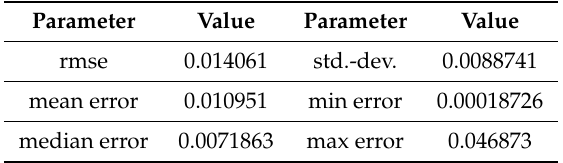
Figure 15. Estimated (red) and ground-truth (blue) trajectories (left), as well as errors over time (right). Dataset: rm4. Unit: [m]. Table 4. Absolute Trajectory Errors (ATE) for Kimera. Dataset: rm4. Unit: